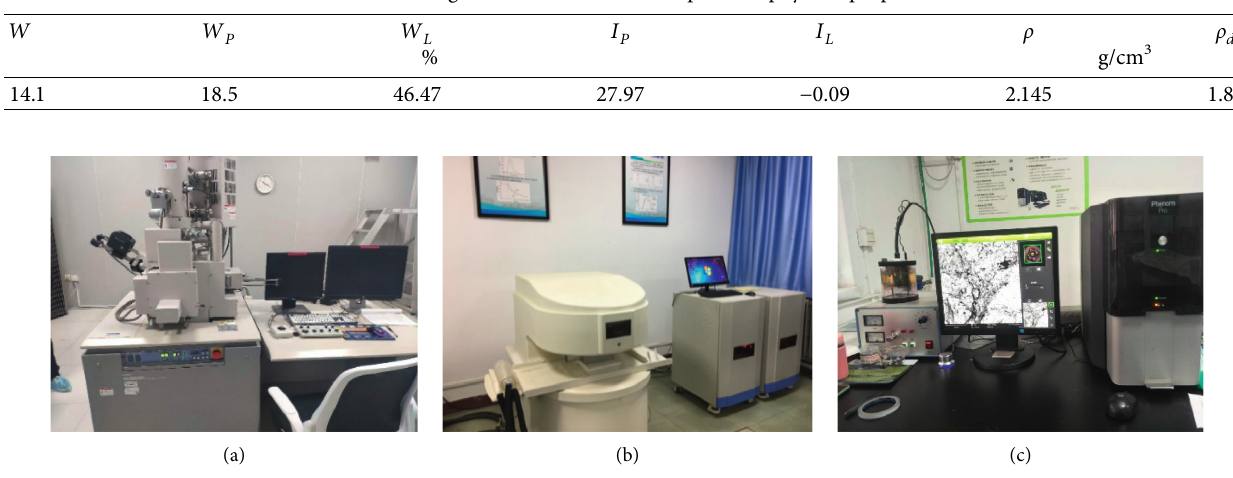
Figure 1: Map of Yinchuan-Xi’an high-speed railway. Table 1: Average values of indicators of paleosol physical properties.